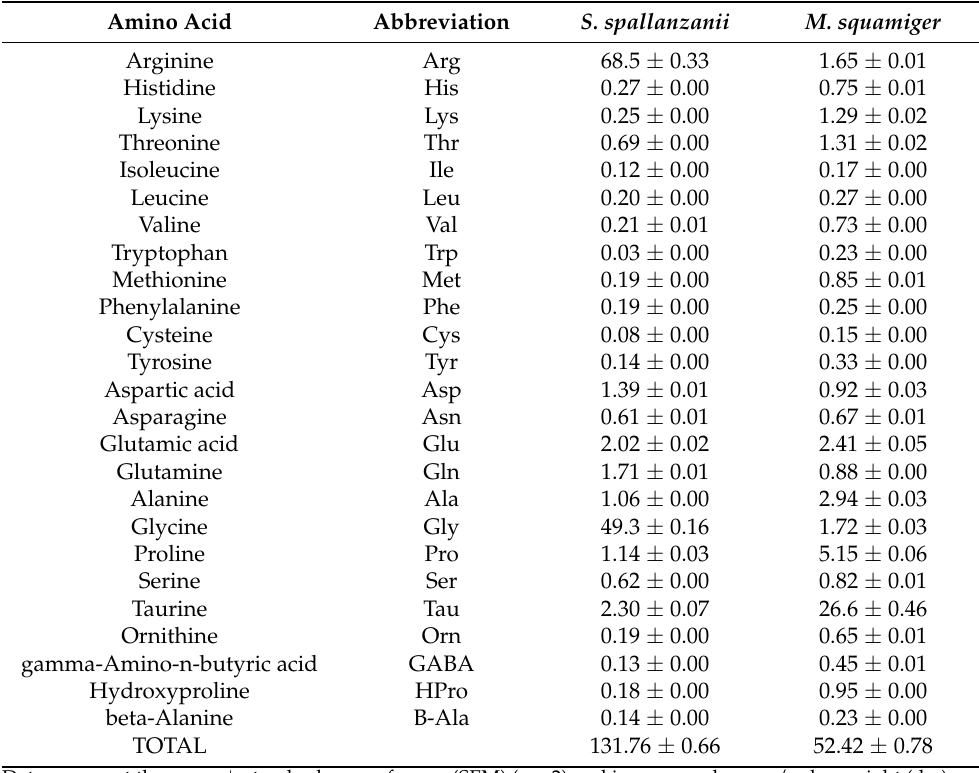
Data represent the mean ± standard error of mean (SEM) ( n = 2) and is expressed as mg/g dry weight